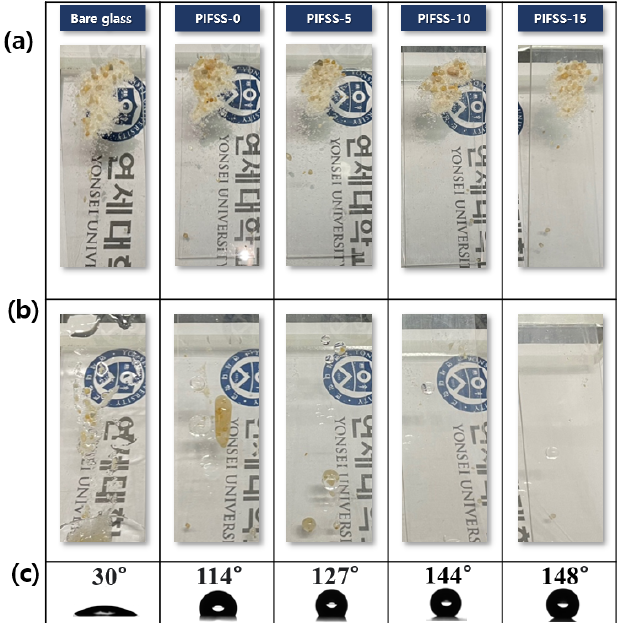
Figure 4. Self-cleaning and water contact angle properties of PIFSS coatings: ( a ) the photos of PIFSS coatings on which a standard sand was sprayed; ( b ) the photos of PIFSS coatings after dropping DI water (0.7 mL) for 3 s; ( c ) the water contact angles of the coating surfaces. To investigate the self-cleaning property, the coating samples were tilted at an angle of 20°. A standard sand specified in ISO 679 (0.2 g) was sprayed on them as shown in Figure 4a, and then 0.7 mL of DI water was dropped using a syringe for 3 s. As shown in Figure 4b, the sands on bare glass, PIFSS-0 and PIFSS-5 were trapped in water droplets without flowing. Although the surfaces of PIFSS-0 and PIFSS-5 had hydrophobic contact angles, they showed insufficient self-cleaning properties at a tilt angle of 20° and under the spraying conditions (0.7-mL water, 3 s). In contrast, PIFSS-10 and PIFSS-15 coatings had good self-cleaning properties: the water droplets with sand pollutants rolled down the coating surfaces. These results showed that the silica sol contents of PIFSS-10 and PIFSS-15 were appropriate to have self-cleaning and high hydrophobic properties. To demonstrate possible application of PIFSS coating, a preliminary test was conducted us- ing a window glass (7 × 4 cm 2 ) coated with PIFSS-10 at a tilt angle of 20°. The standard sand (0.5 g) was sprayed and then DI water (1.5 mL) was dropped using a syringe for 5 s. It was observed that the water droplets with sand pollutants rolled down the coating sur- face, and the coated window glass was cleaned. 3.3. Transeparency of PIFSS Coatings Figure 5 shows the optical transmittance of PIFSS coatings in the range of 200~800 nm. At 550 nm, PIFSS-0, PIFSS-5, PIFSS-10 and PIFSS-15 showed transmittance values of 90%, 89%, 88% and 82%, respectively. PIFSS-20 sample was excluded because it was trans- lucent and brittle. As the silica sol content was increased in PIFSS samples, the optical transmittance reduced. The reason of decreasing optical transmittance is that the silica sol particles in PIFSS samples make rough surface on coating. Such a roughness is detrimental